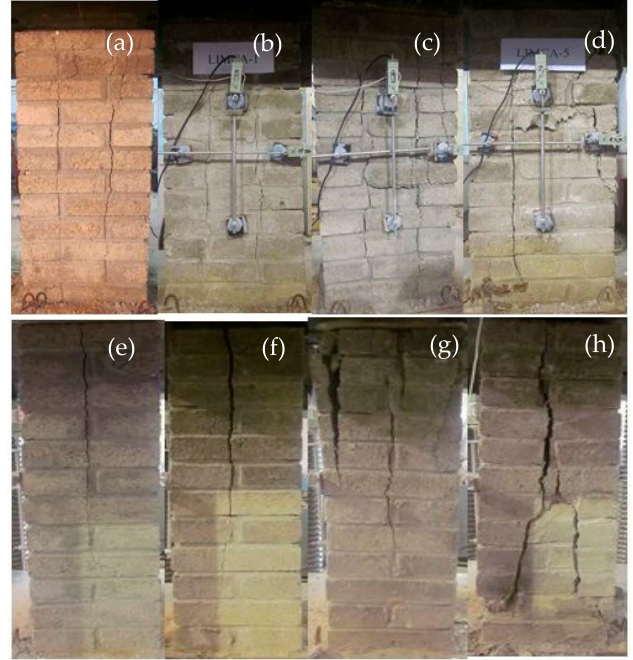
Figure 12. Failure pattern of compression specimen under a different corrosion cycle. ( a ) Wide side of KYMA. ( b ) Wide side of KYMB. ( c ) Wide side of KYMC. ( d ) Wide side of KYMD. ( e ) Narrow side of KYMA. ( f ) Narrow side of KYMB. ( g ) Narrow side of KYMC. ( h ) Narrow side of KYMD.